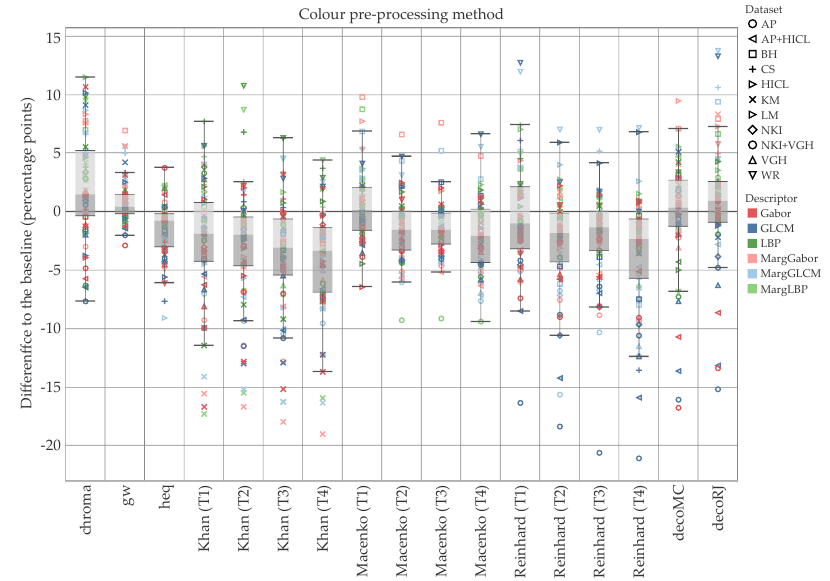
Figure 8. Difference to the baseline for each of the color pre-processing methodologies (texture and hybrid hand-designed descriptors). Color shows details about descriptor, shape about data set. The data are filtered on f = 4. The zero line represents the condition where no color pre-processing was